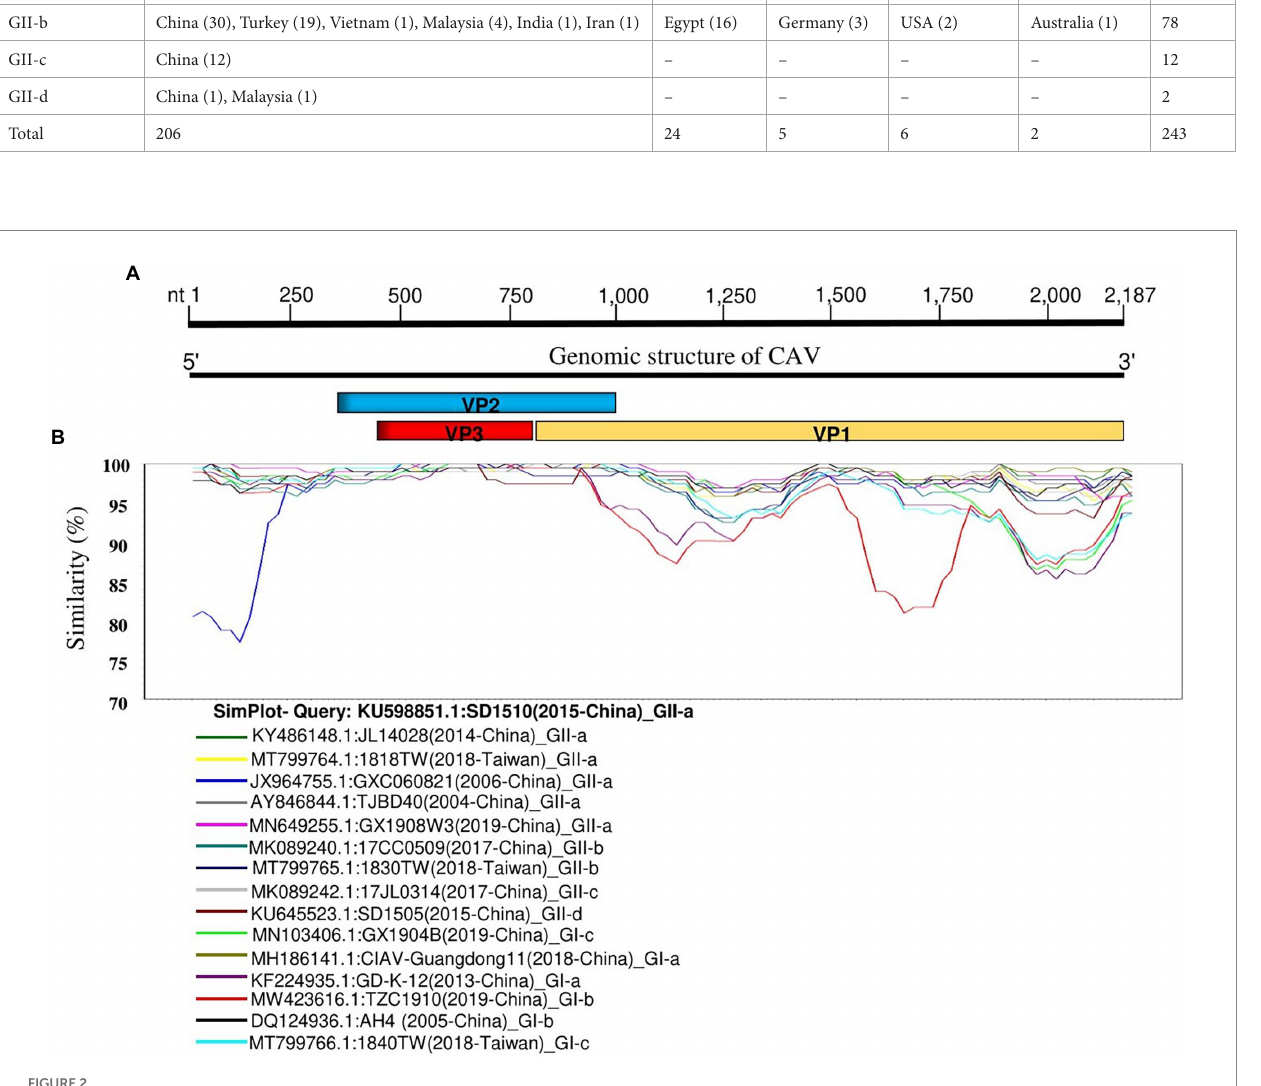
(Figure 3). In addition, the CAV vaccine strain 3,711 (GenBank ID: